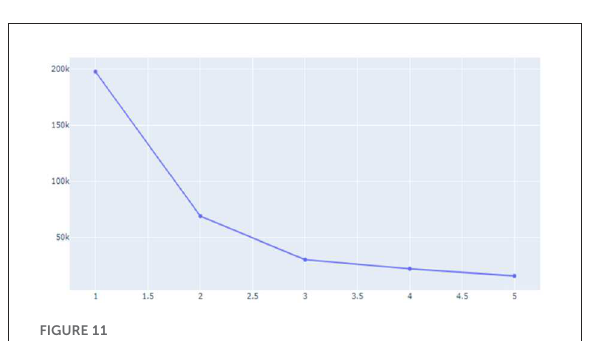
FIGURE10 Result of hierarchical clustering.